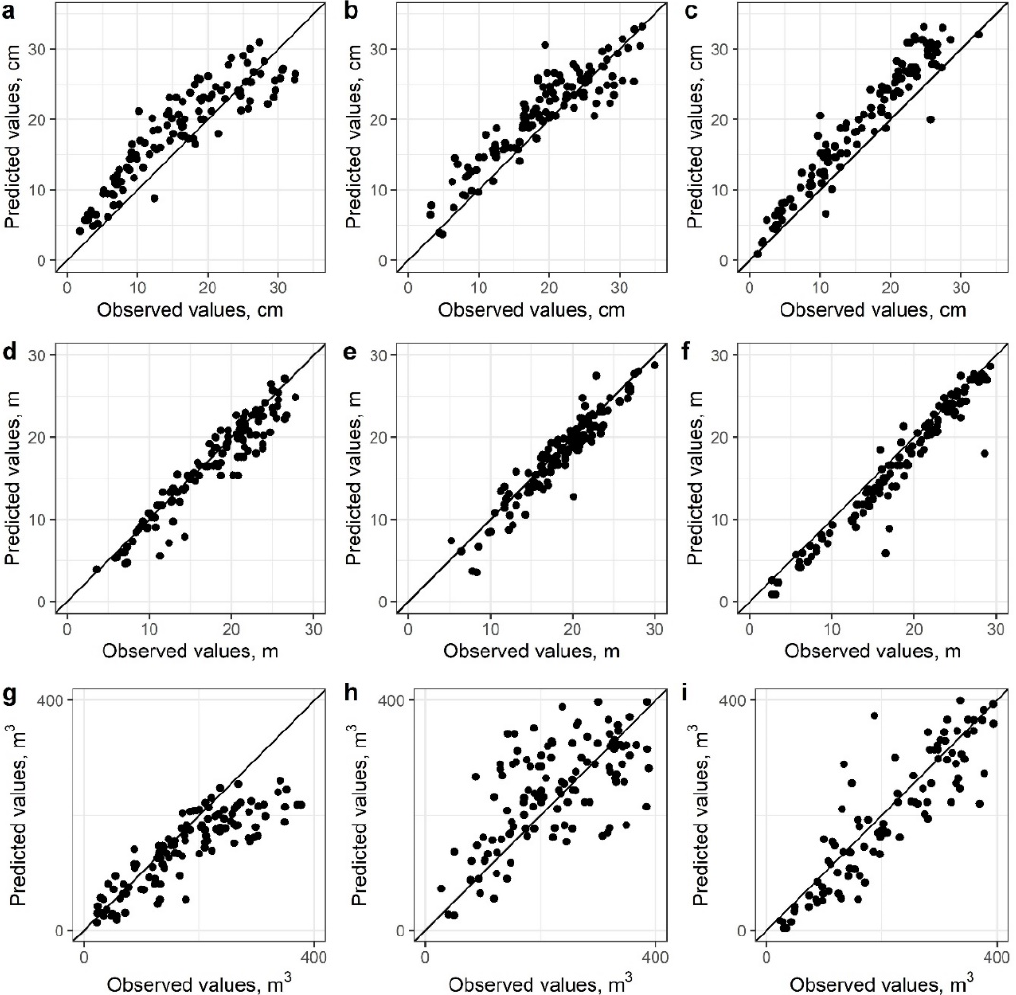
Figure 1. Observed versus predicted values: top row indicates D, middle - H and bottom - GSV. Plots are arranged according tree species: ( a , d , g —Silver birch; b , e , h —Black alder; c , f , i —Common aspen). Red line illustrates 1:1 agreement between values.